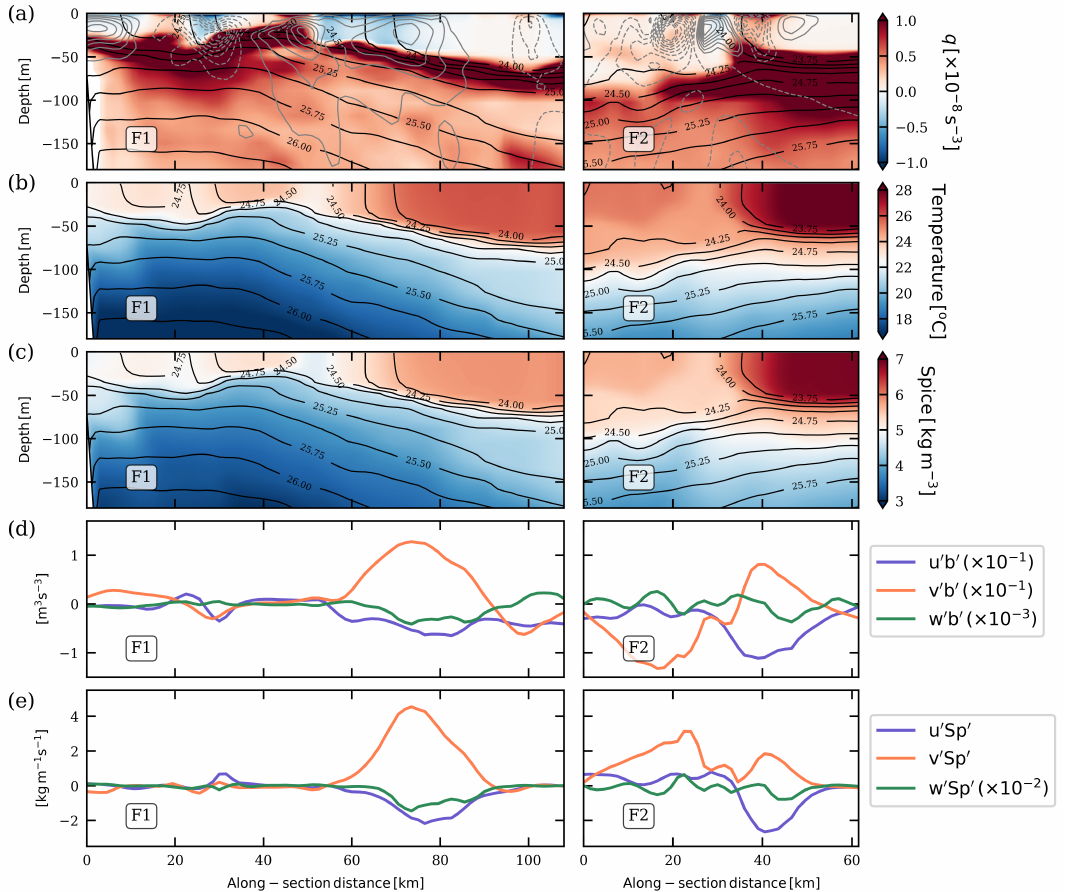
Figure 4. Vertical section of ( a ) Ertel potential vorticity, ( b ) temperature, ( c ) spiciness, and ( d , e ) buoyancy and spiceness turbulent fluxes integrated from the surface down to 50 m depth. ( a – c ) Density contours are drawn in black solid lines. ( a ) Grey contours stand for the vertical velocity computed from the ω